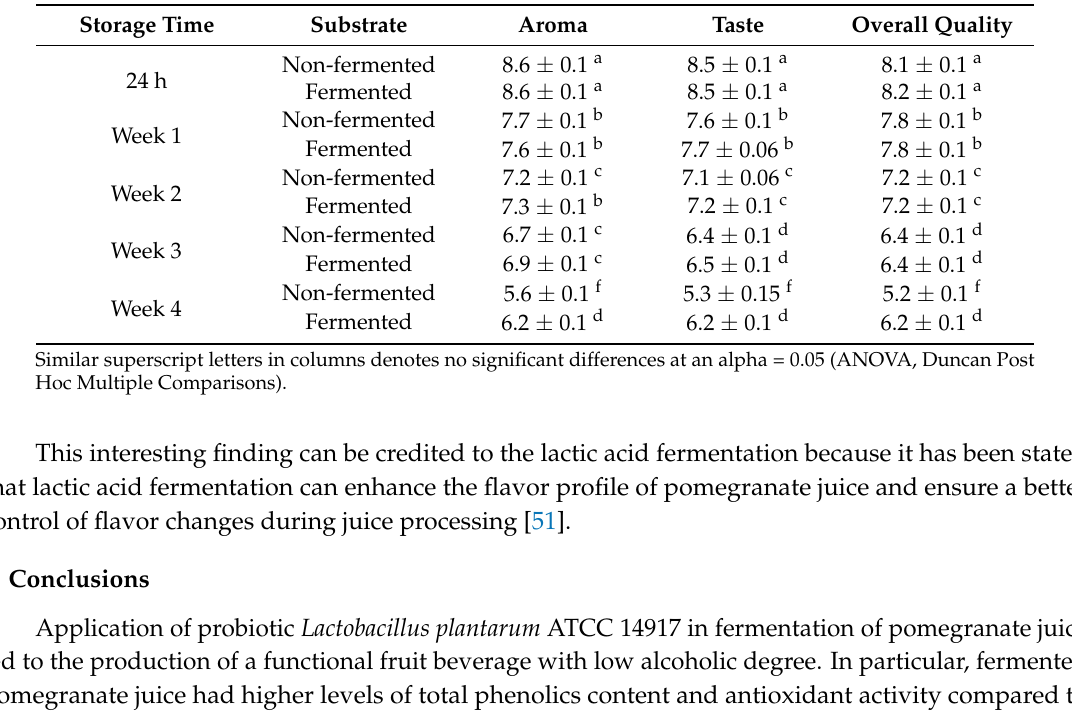
Table 4. Preliminary sensory evaluation of non-fermented and fermented pomegranate juice with Lactobacillus plantarum ATCC 14917 cells during 4 weeks of cold